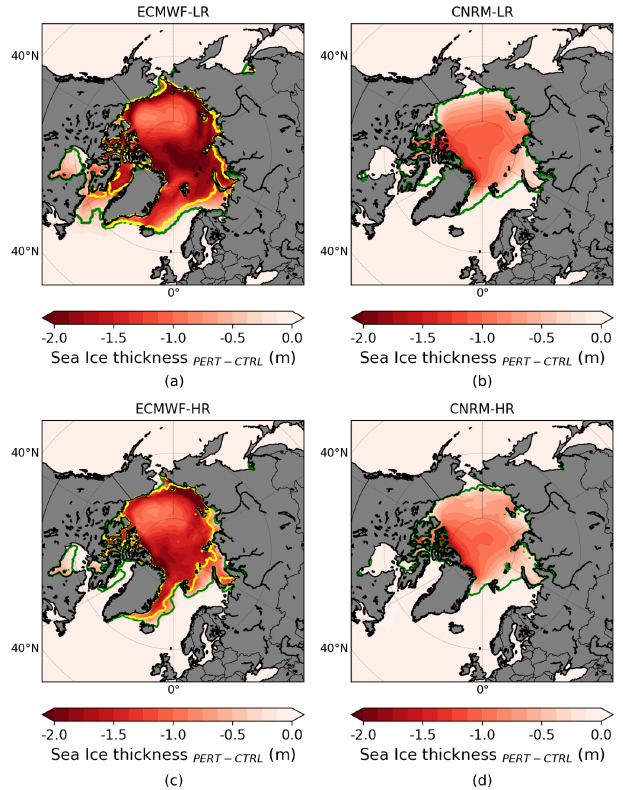
Figure A2. Arctic sea ice thickness change (PERT − CTRL) in sum- mer (JAS) in ECMWF-LR (a) and CNRM-LR (b) . (c–d) As (a) – (b) but for models at high resolution. The green and yellow lines show the sea ice edge (15% ice concentration) from CTRL and PERT, respectively. Note that for the two CNRM model configurations, no yellow line is present because the sea ice has disappeared in PERT.